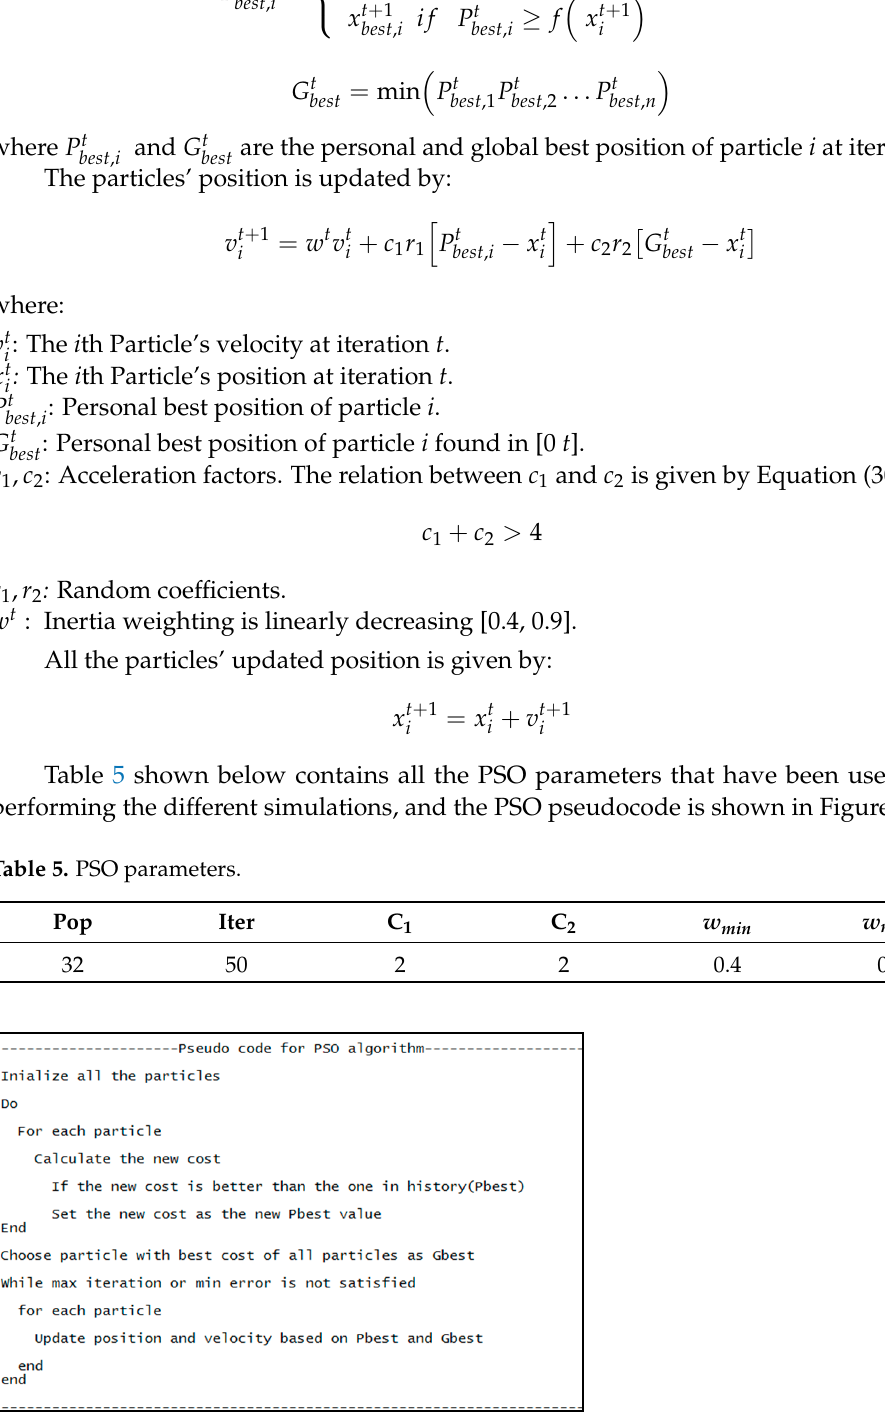
Figure 7. Pseudo code of PSO algorithm.